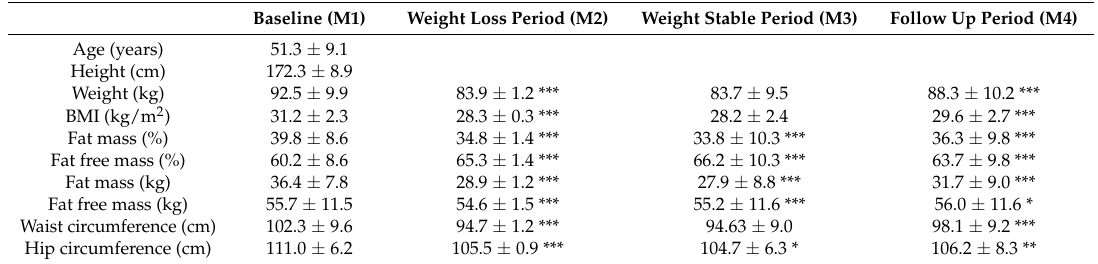
Table 1. Changes in anthropometric data throughout the weight loss intervention.